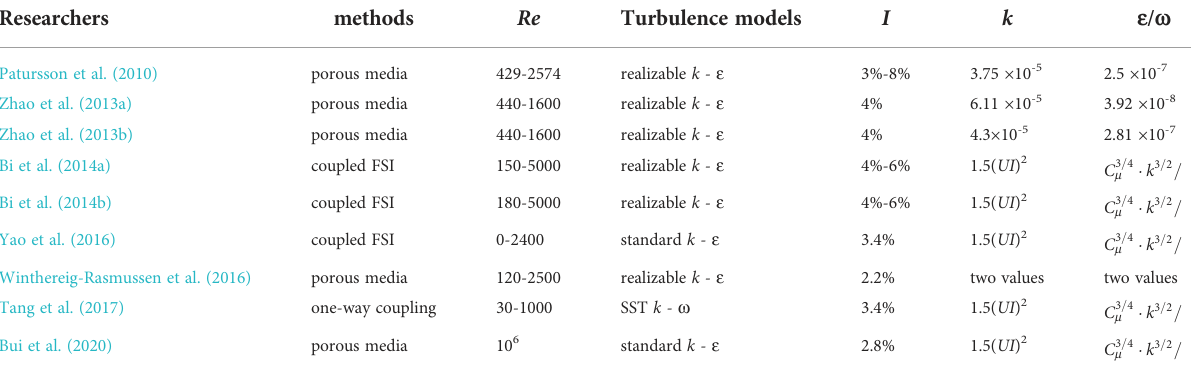
TABLE 1 Summary of turbulence models applied to fl ow through aquaculture